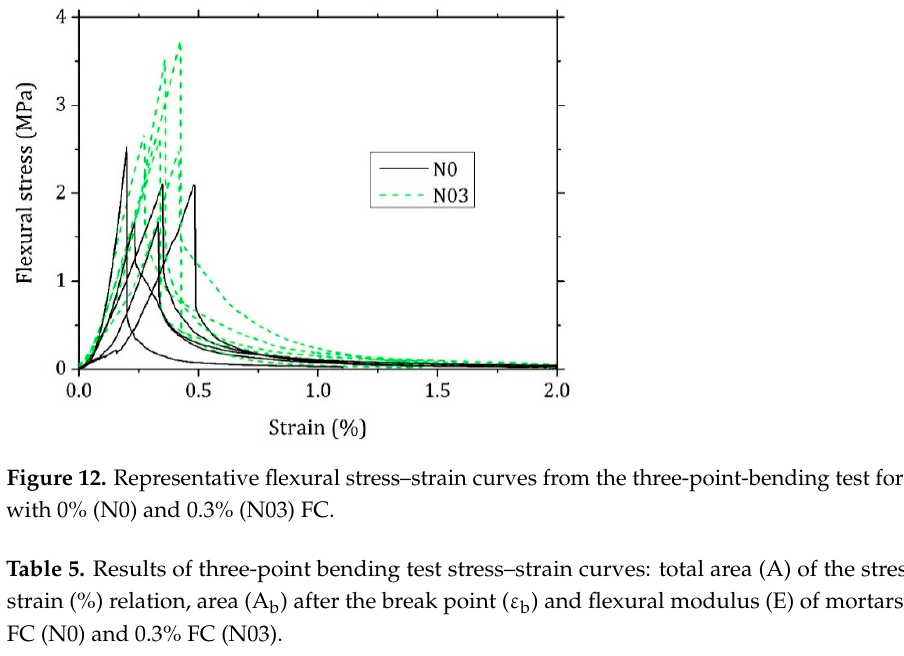
FC (N0) and 0.3% FC (N03).